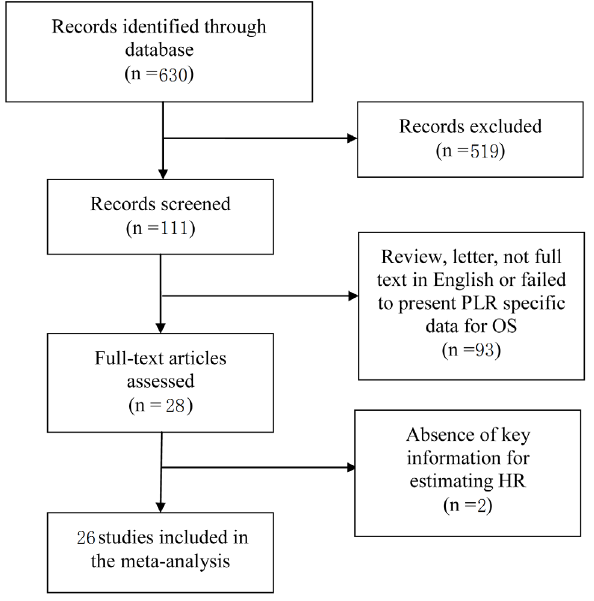
Figure 1. Methodological flow diagram of the meta-analysis.